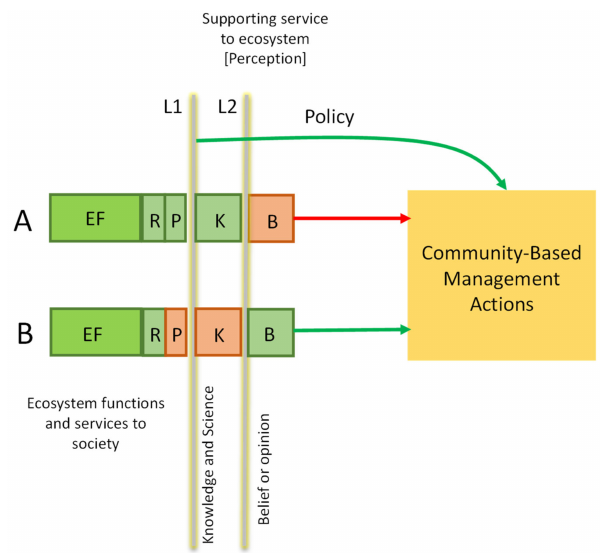
Figure 2. Components of ecosystem functions (EF), tangible ecosystem services (regulating (R) and provisioning (P)) and associated supporting services to ecosystems as derived from knowledge (K) and beliefs (B) viewed through associated knowledge (L1) and belief (L2) lenses. Note that conservation ‘policy’ (without voting referendums or direct community representation) is largely derived from knowledge and science. Green symbols indicate positive ‘values’ or services, orange symbols indicate negative values or disservices. ( A ) indicates a case whereby a cultural disservice, related to community beliefs, negates a recognized ecosystem service to become a potential barrier to conservation. ( B ) indicates a scenario whereby a cultural service related to some community belief disregards a recognized ecosystem disservice to support a conservation initiative. Note that knowledge and/or beliefs will not exist for all raptor species—in many cases, cognitive associations with raptors will be weak (positive or negative) or